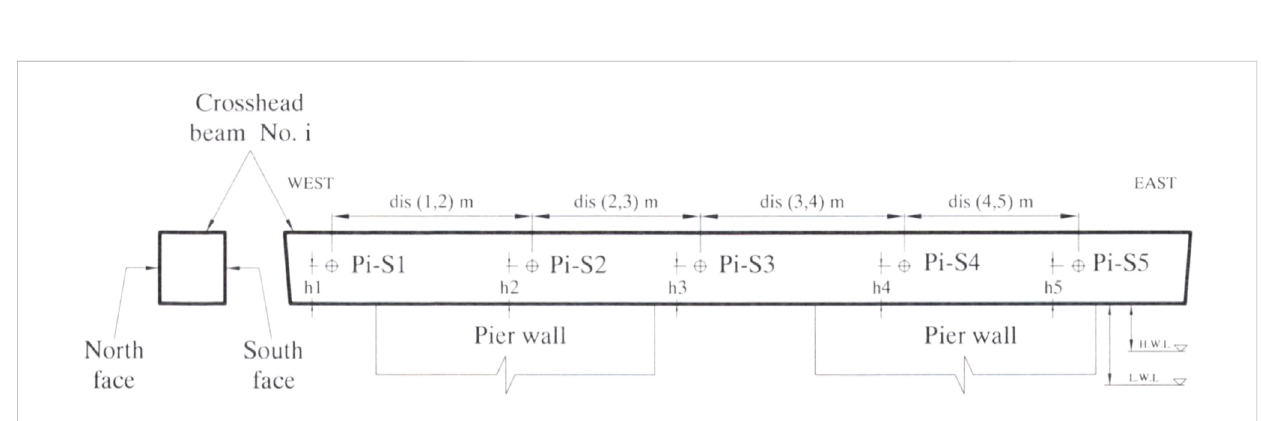
FIGURE 2 Cores symbolizing system (Kenshel, 2009, pp.